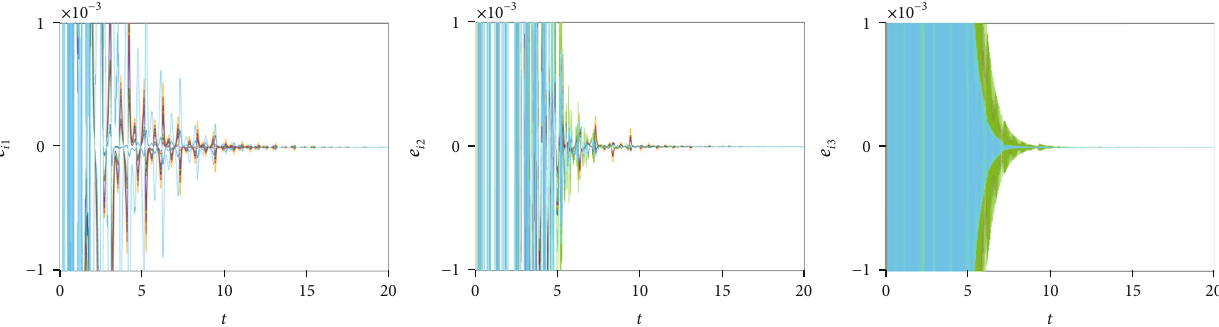
Figure 9: Partial ampli fi cation of synchronization errors e